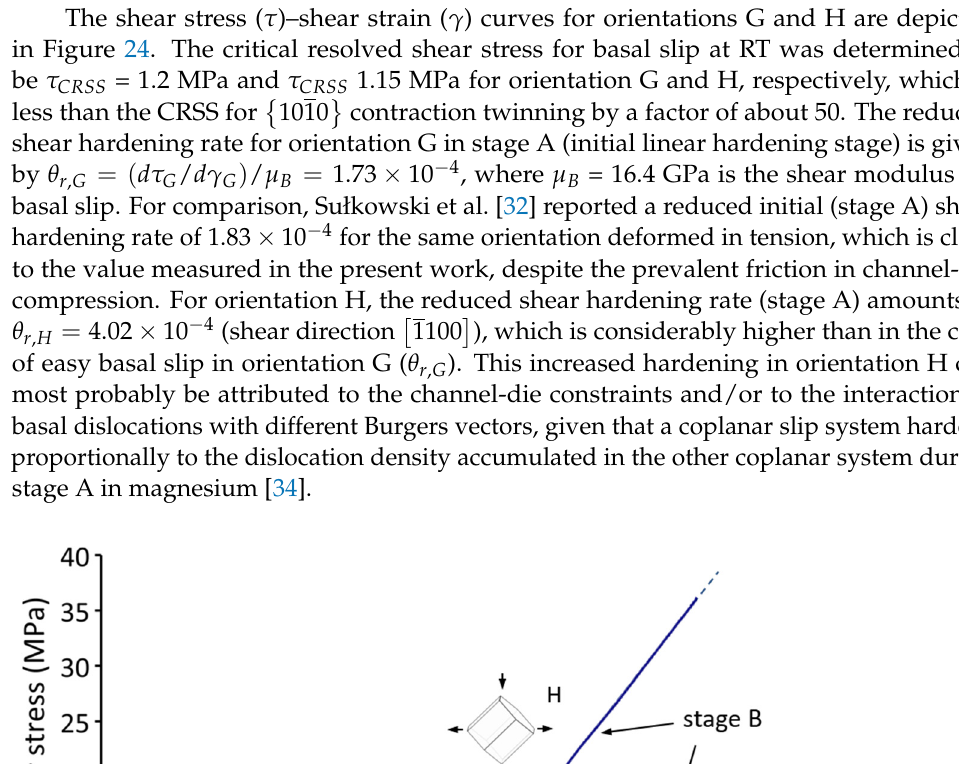
Table 2. Schmid factors (SF) for the respective slip directions for basal slip in crystals of orientations G and H.